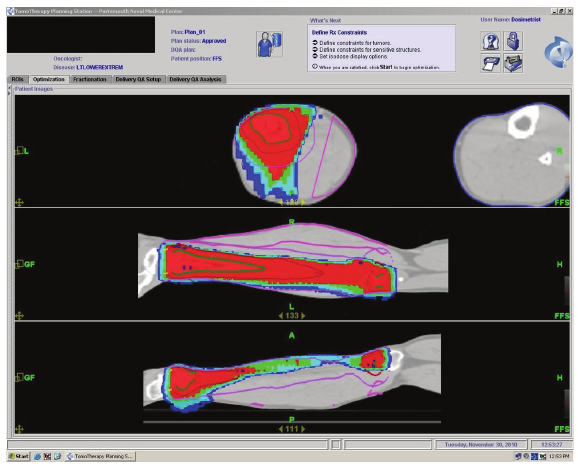
Figure 2: Tomotherapy planning study images demonstrating dose distribution and relative sparing of posterior